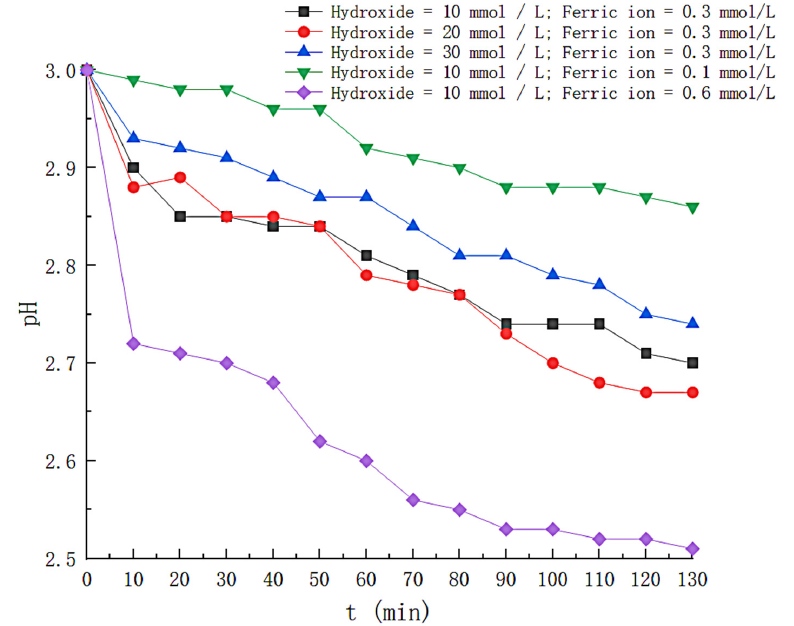
Figure 12. Variation of pH under different conditions.